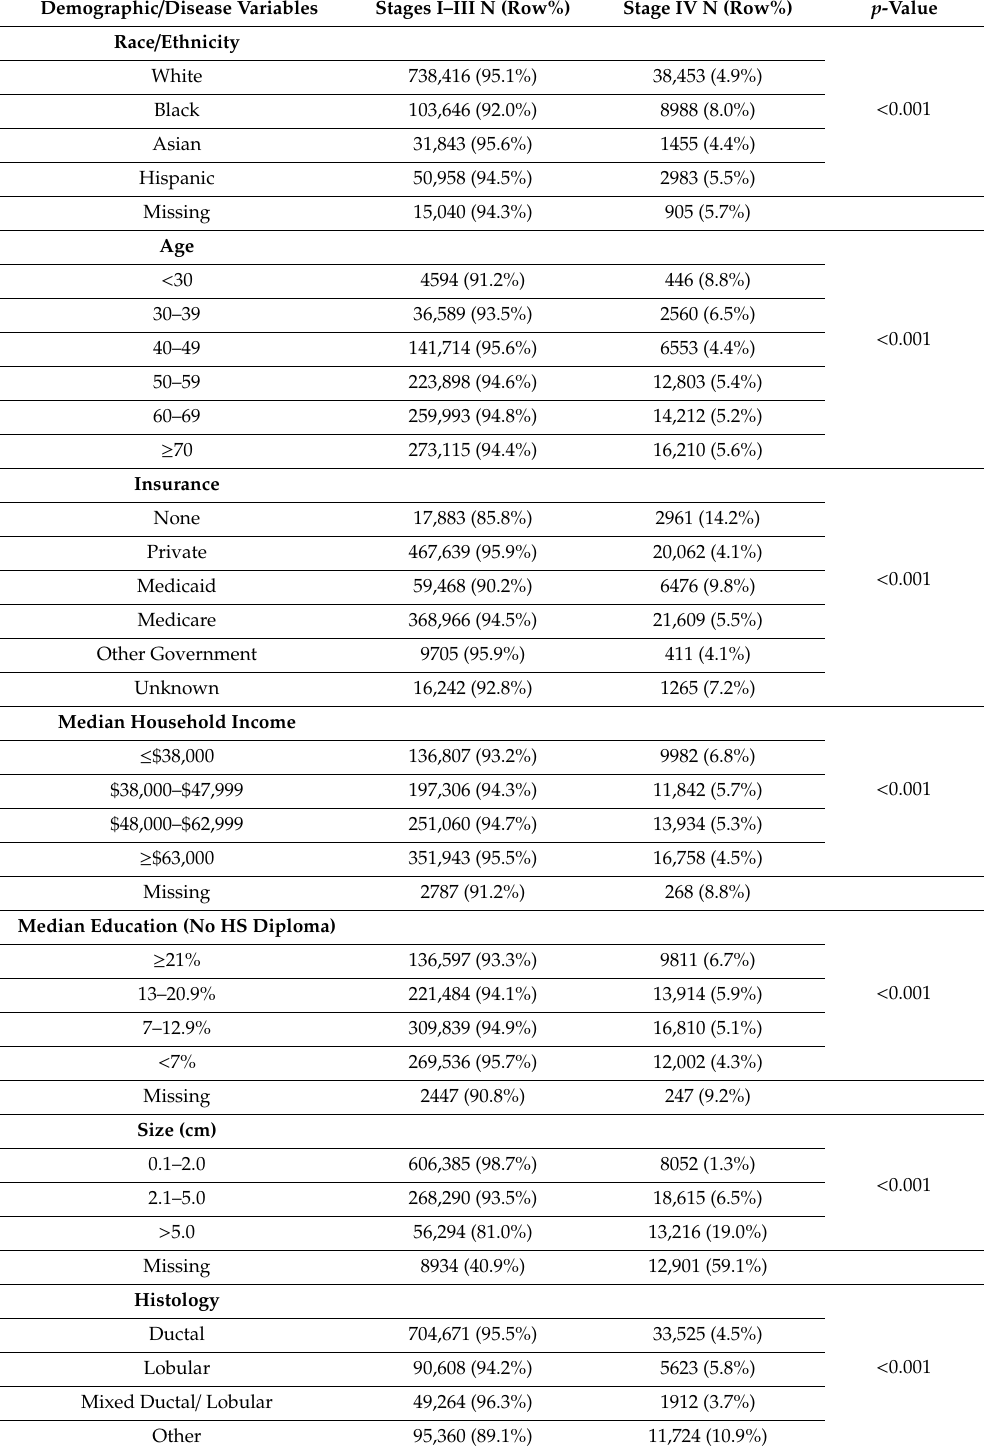
Table 2. Univariable analysis of demographic and disease variables for American Joint Committee on Cancer Stages I–III and Stage IV. HS: high